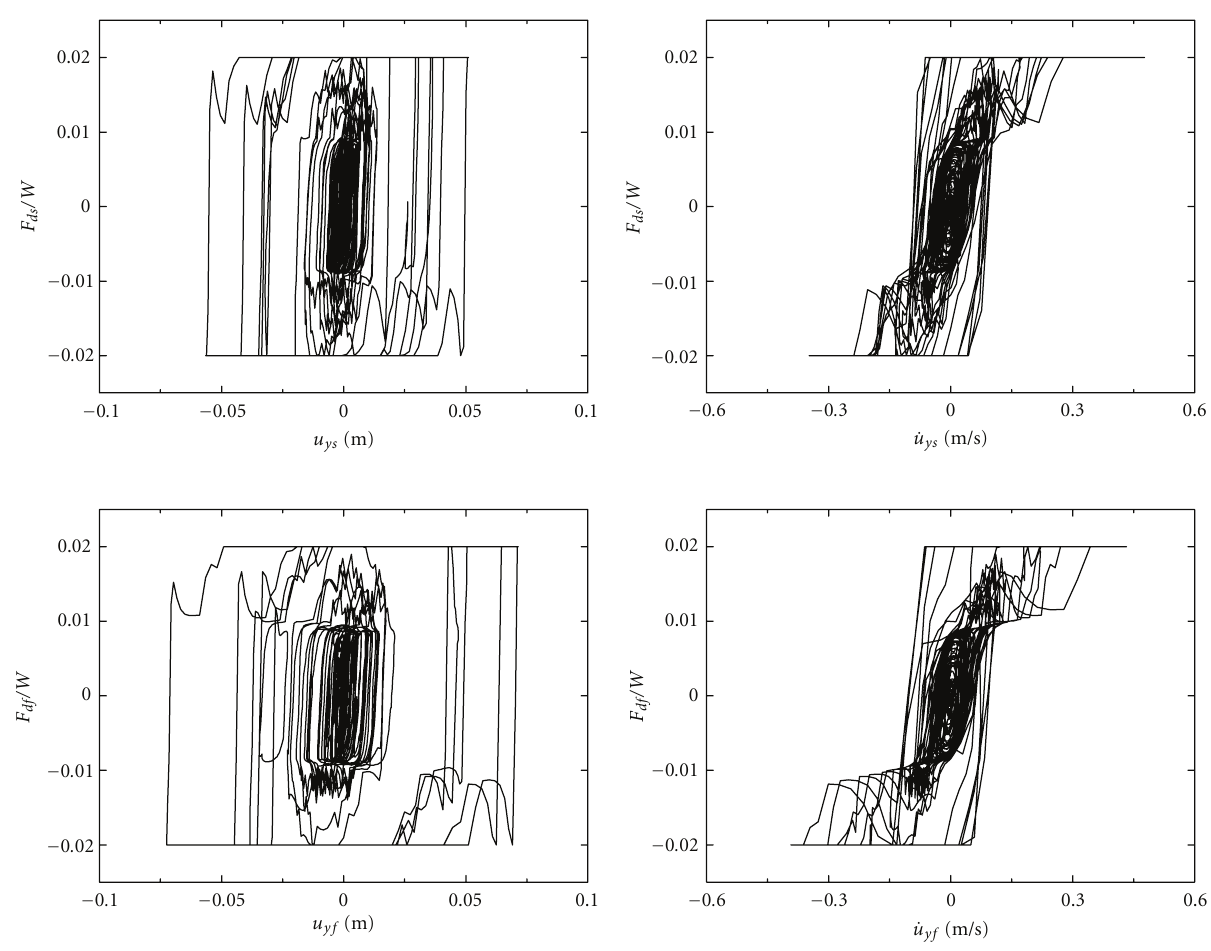
Figure 8: Normalized damper force-displacement and velocity loops for dampers located at sti ff and flexible edges for semiactive clipped- optimal control algorithm under Imperial Valley, 1940 earthquake ( T y = 1s, Ω θ = 1, e x / r = 0 . 3).